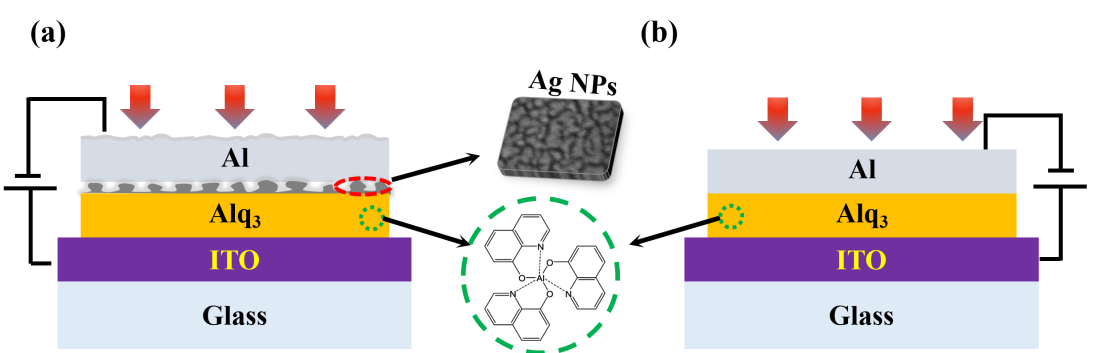
Figure 1. ( a , b ) Schematic diagrams of OPDs in cross-sectional view composed of ITO/Alq 3 /AgNP/Al and ITO/Alq 3 /Al. The insets in the middle are the molecular structure of Alq 3 ( bottom ) and the schematic diagram of the Ag NP layer ( top ).